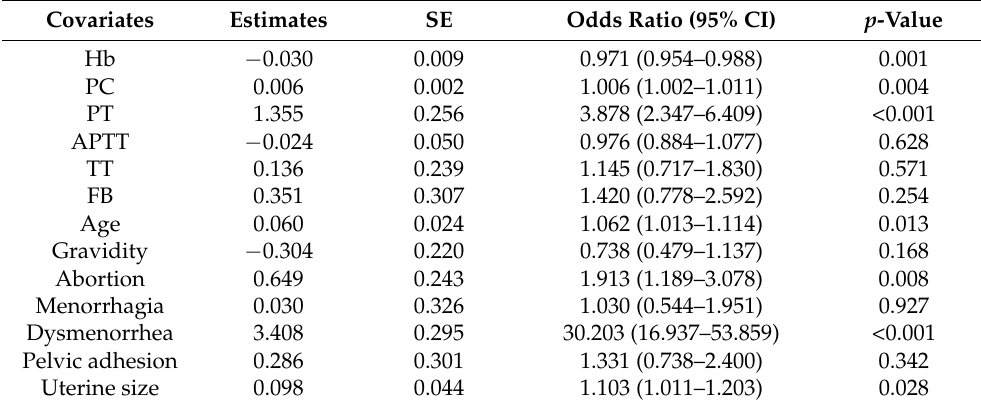
Table 3. Correlations of coagulation parameters and adenomyosis.